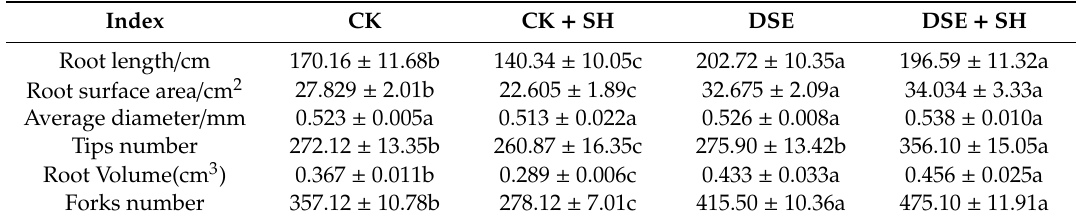
Table 2. DSE inoculation e ff ect on the root structures of seedlings.